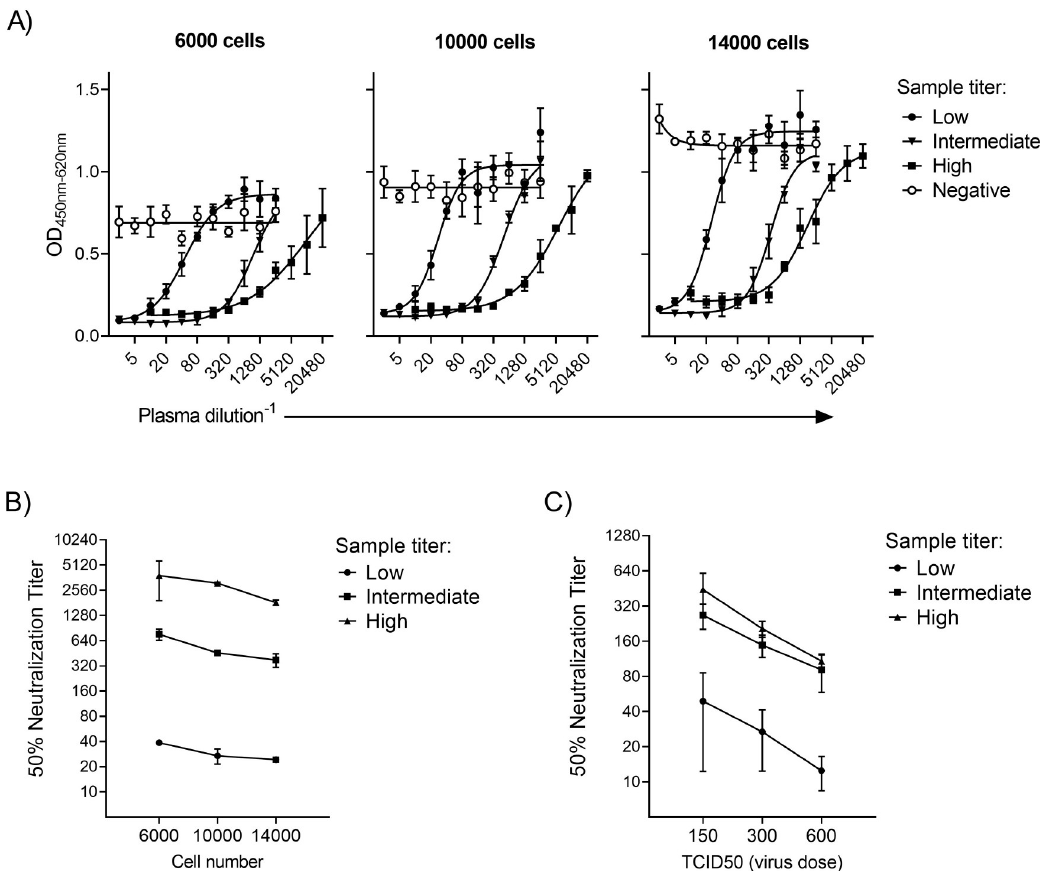
Fig 3. Effect of variable Vero E6 cell number and virus amount on assay sensitivity. (A) Four serum samples of known neutralization titer (negative, 1:10, 1:160 and 1:1280) were tested in the neutralization assay (early pandemic strain (lineage B.1)) with different Vero E6 cell numbers seeded the day prior (6000, 10000, or 14000). Lines represent the four-parameter titration curve calculated from the mean of triplicate measurements. (B) Neutralization titers for assays using 6000, 10000 and 14000 cells seeded the day prior. (C) Neutralization titers for three samples from assays using 10000 cells and different amounts of input virus (150, 300 and 600 TCID 50 ). Each data point represent the mean of triplicate determinations with standard deviation. For all experiments, ELISA primary antibody: rabbit mAb